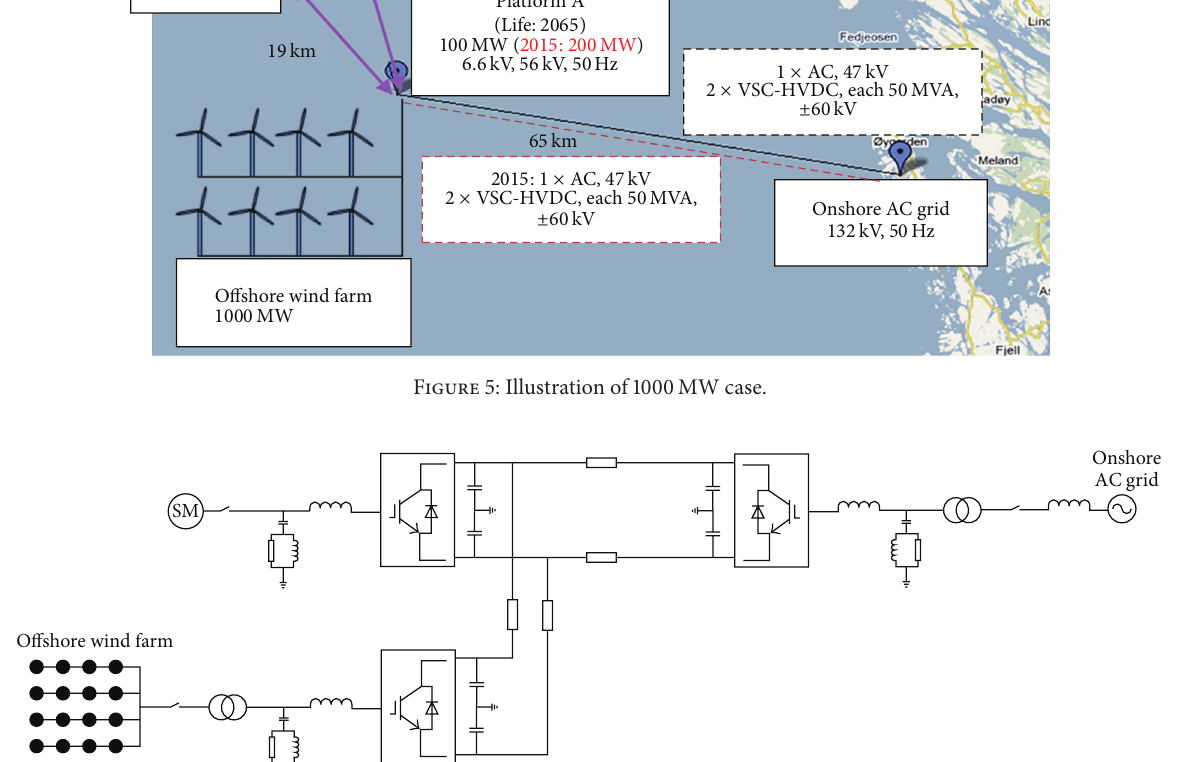
Figure 6: One proposal of the 1000MW offshore wind farm